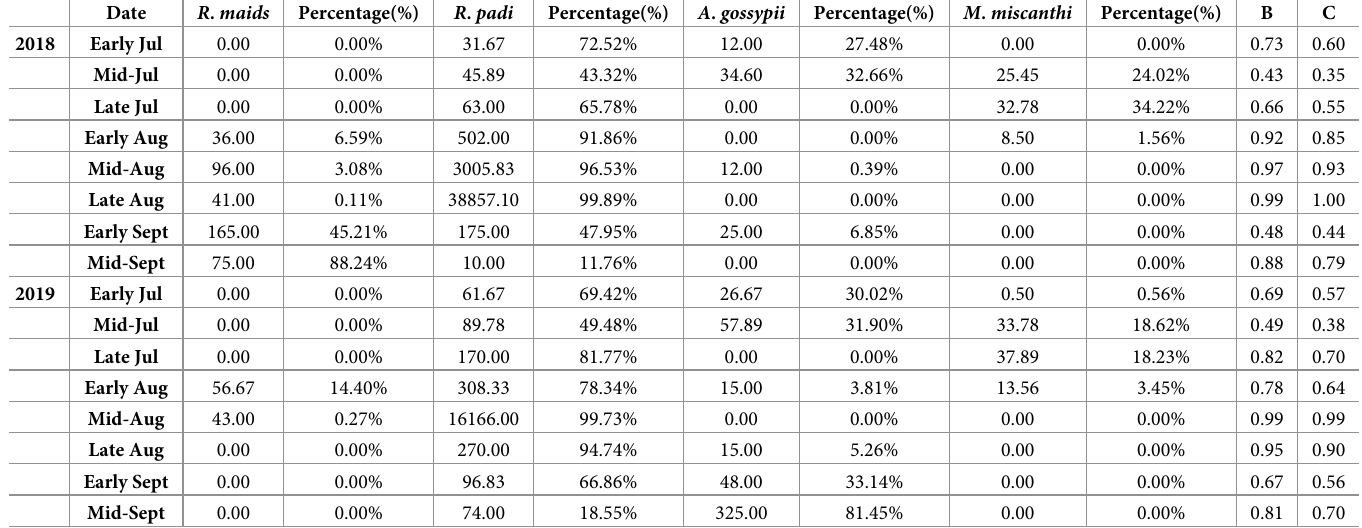
Table 2. The population dynamics and dominance of aphids in Songyuan area maize field in 2018 and 2019.